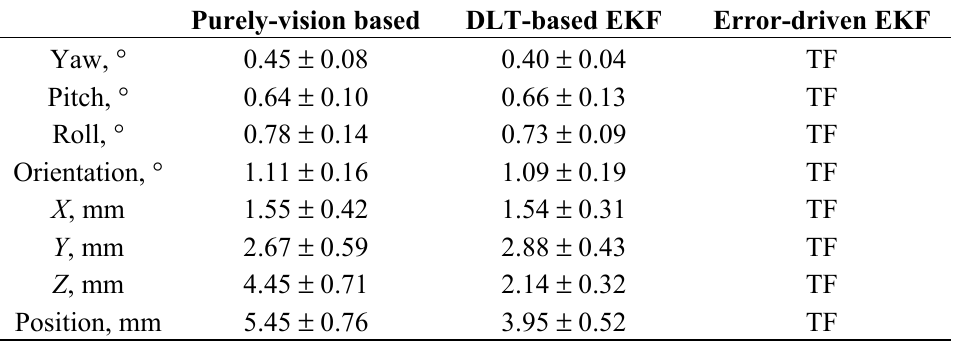
Table 2. Summary statistics of the performance metrics in the scenario (a).